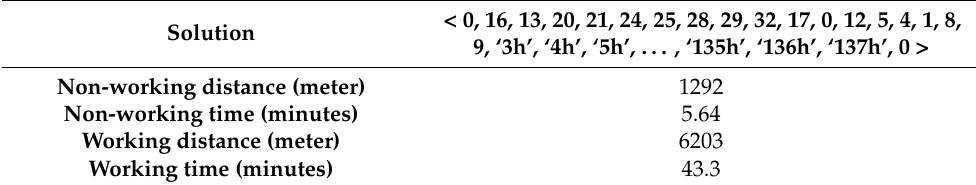
Table 5. The optimized field coverage plan with the results of the simulation model for the fertilizing operation by a distributer with the capacity of 25 m3 in the sample